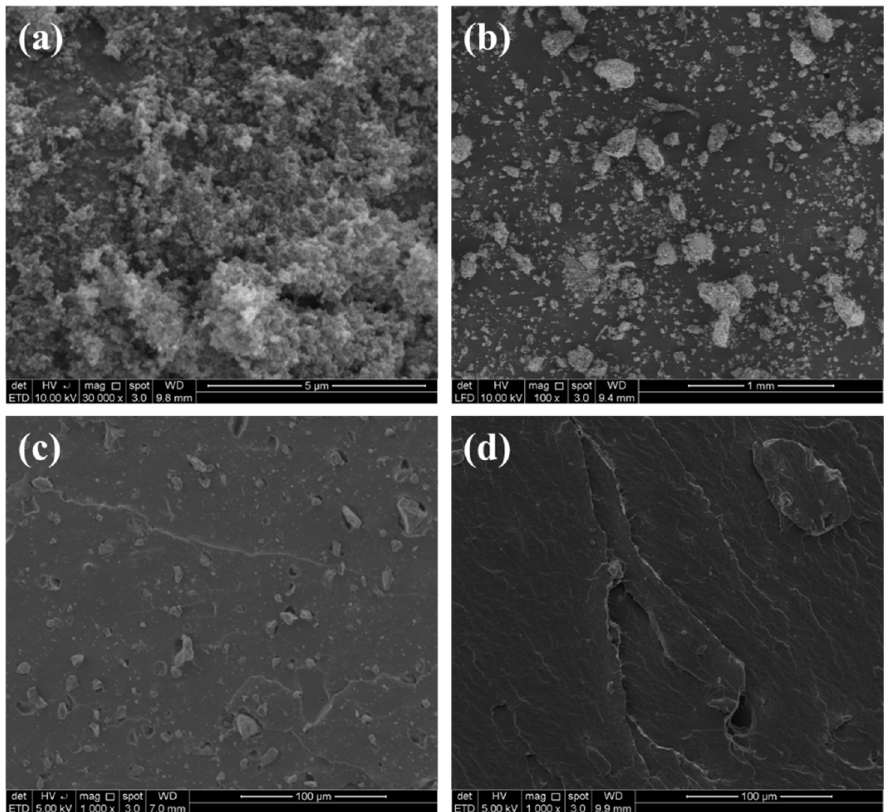
Figure 9. ( a ) SC ( b ) Biochar ( c ) ENR ‐ BIOCHAR ‐ 10 phr ( d ) ENR ‐ CB ‐ 10 phr.